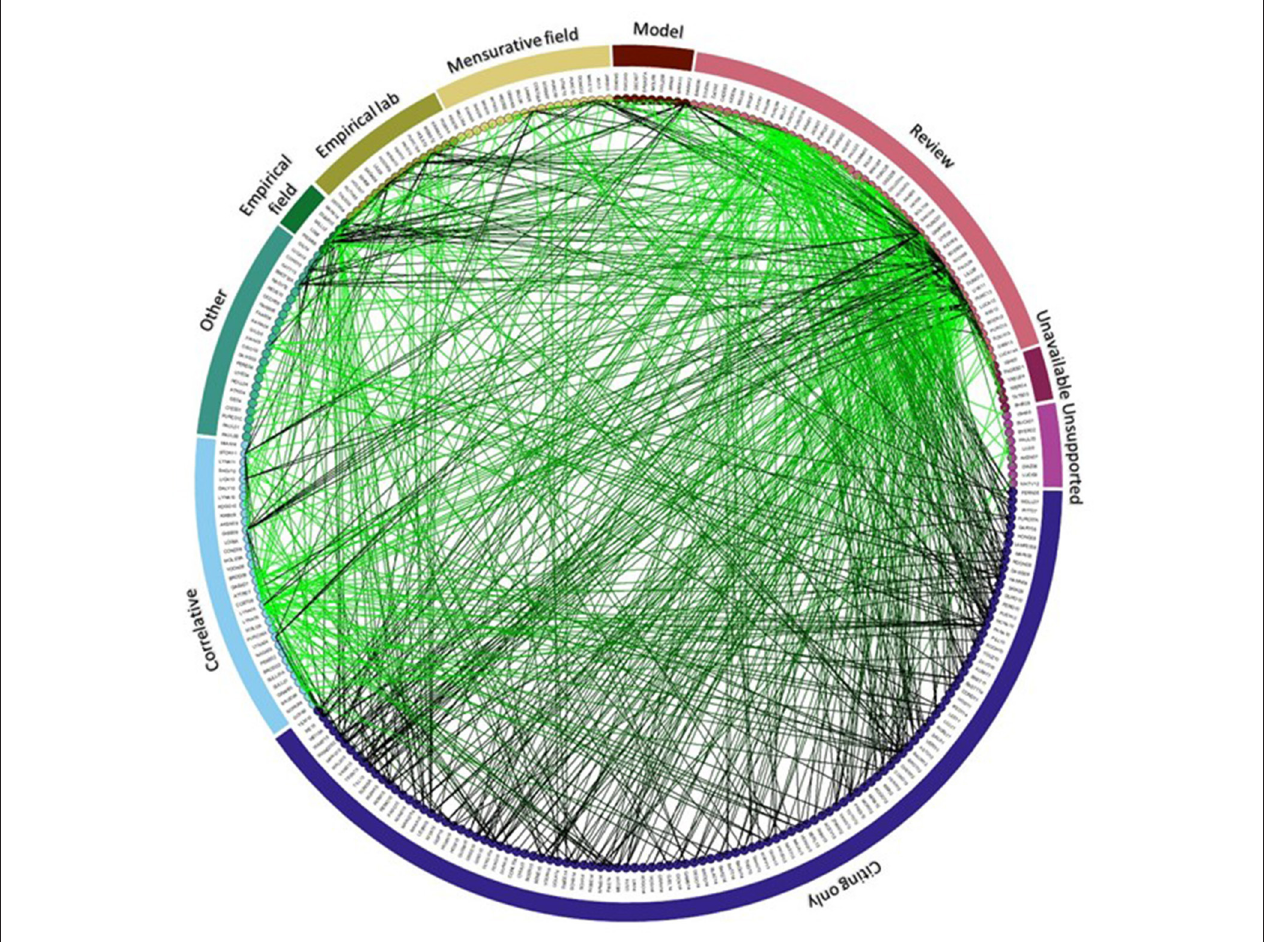
FIGURE 3 | Network of citations. Nodes represent papers and lines connect citing and cited papers; the color of the line transitions from black (citing paper) to green (cited paper). Cited papers are arranged according to type of study and then chronologically (arranged clockwise). Individual papers are identified using a code available in Table S1